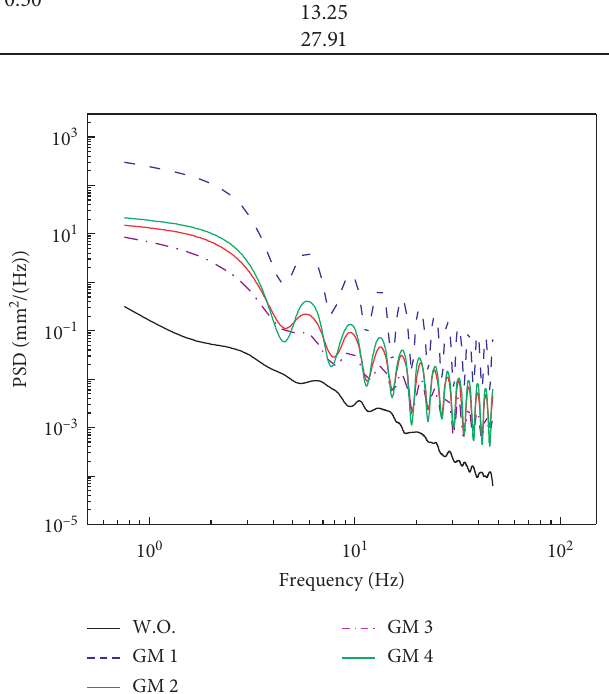
Figure 16: PSD of alignment irregularities under different earthquake